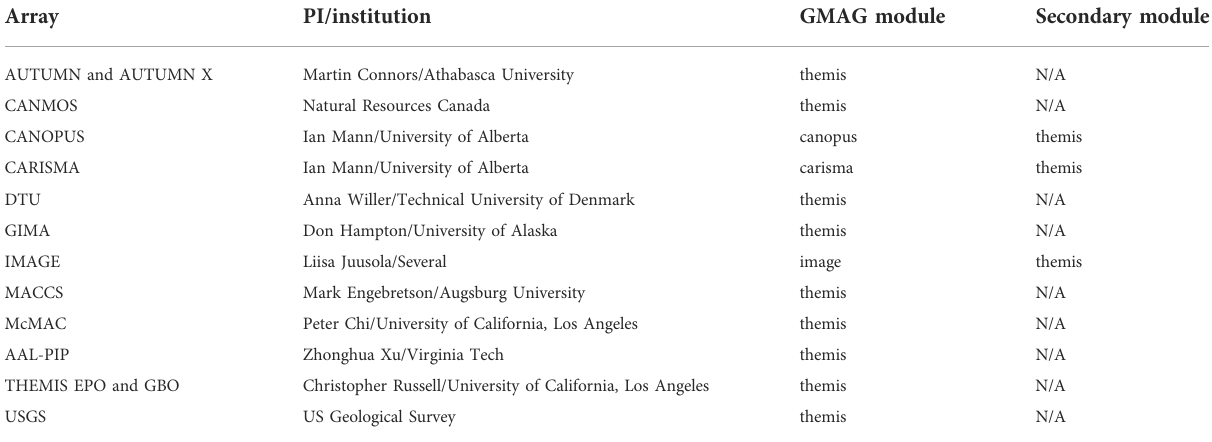
TABLE 1 The ground-based magnetometer arrays that can be accessed by the GMAG package.